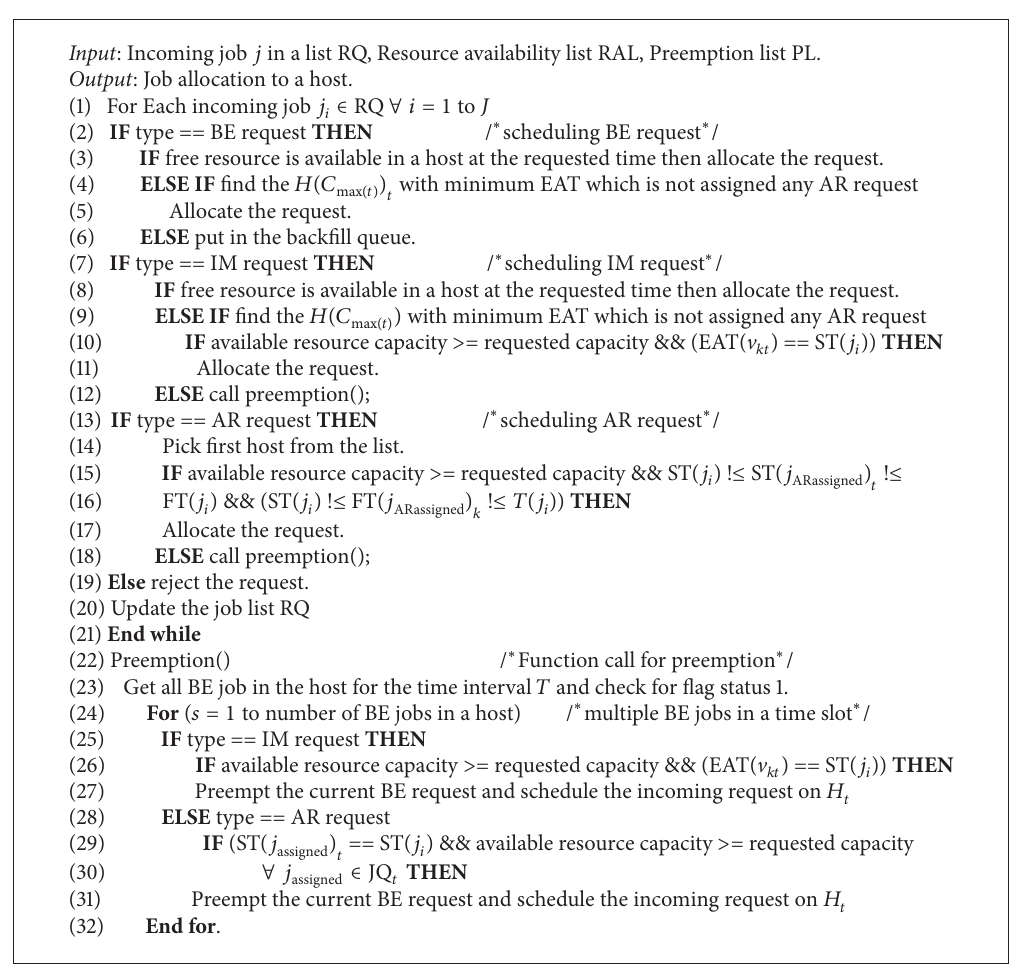
Algorithm 1: Modified best fit with capacity based scheduling